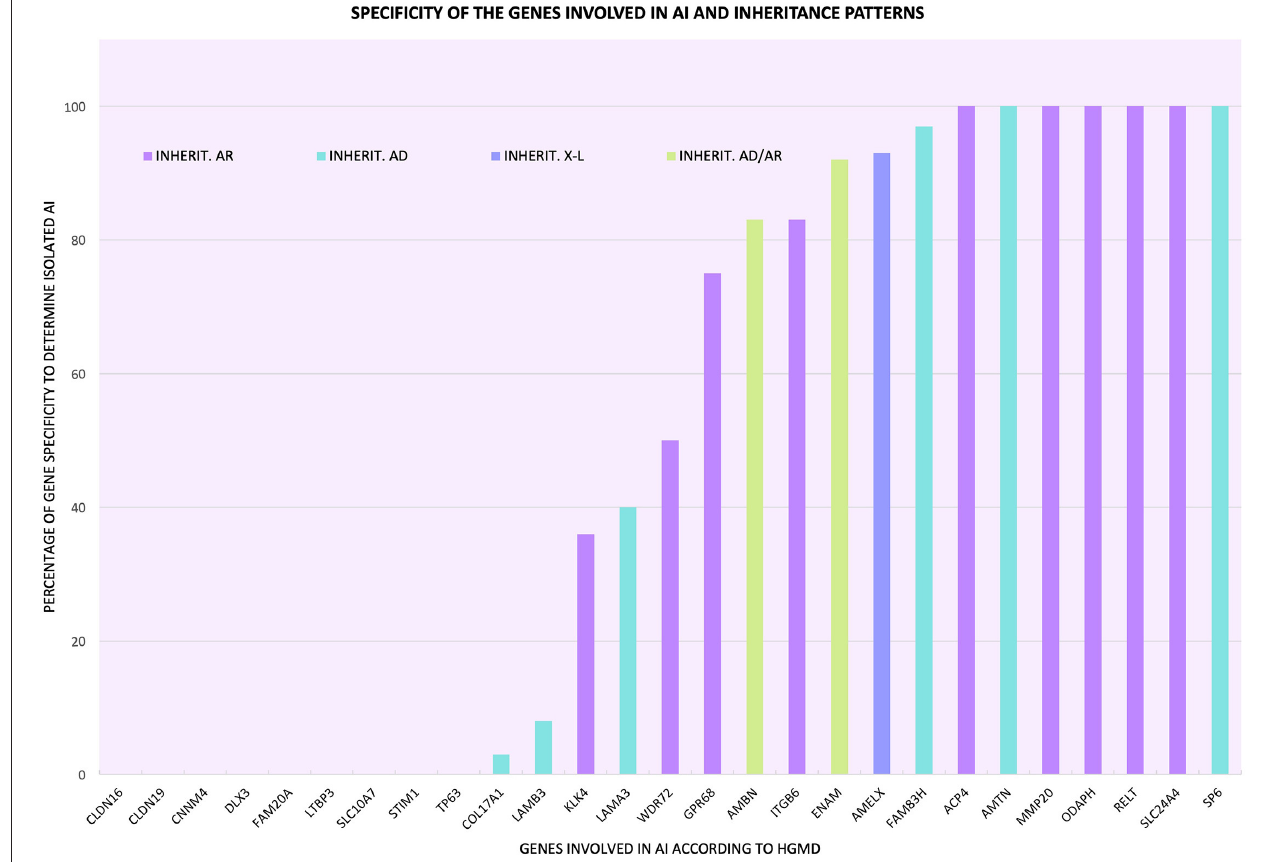
FIGURE 1 | Percentage of specificity of the genes involved in AI to determine the phenotype in isolation form and inheritance patterns associated with the mutations of each gene ( autosomal recessive inheritance; autosomal dominant inheritance; X-linked inheritance; autosomal dominant inheritance in some cases and autosomal recessive inheritance in other cases).